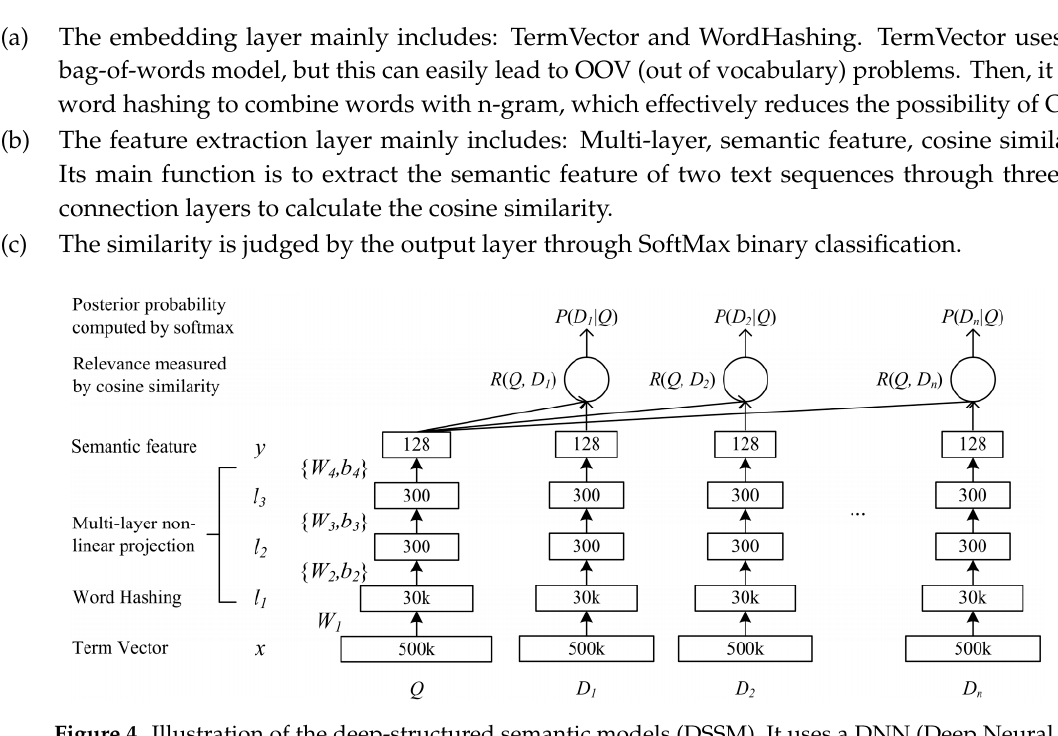
Figure 4. Illustration of the deep-structured semantic models (DSSM). It uses a DNN (Deep Neural Networks) to map high-dimensional sparse text features into low-dimensional dense features in a semantic space [48].